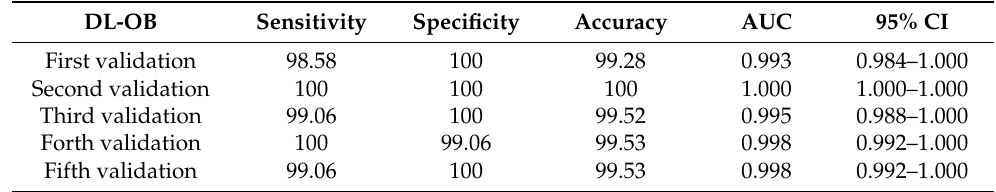
Table 4. Results summary of five-fold, cross-validation of DL-OB model for detecting over-scanning at the lung bases (CI, confidence